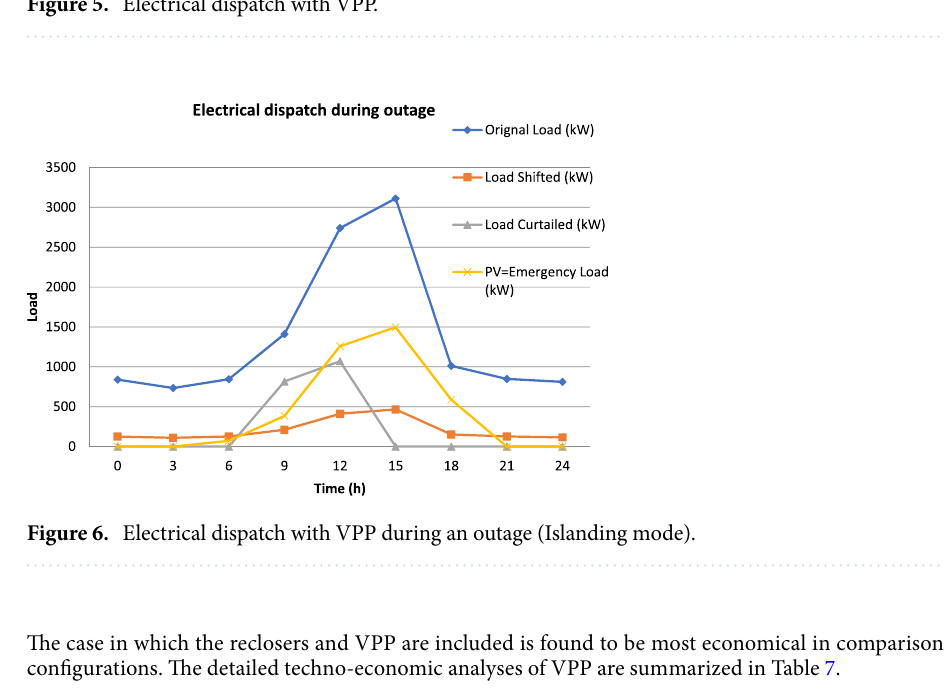
Figure 5. Electrical dispatch with VPP.